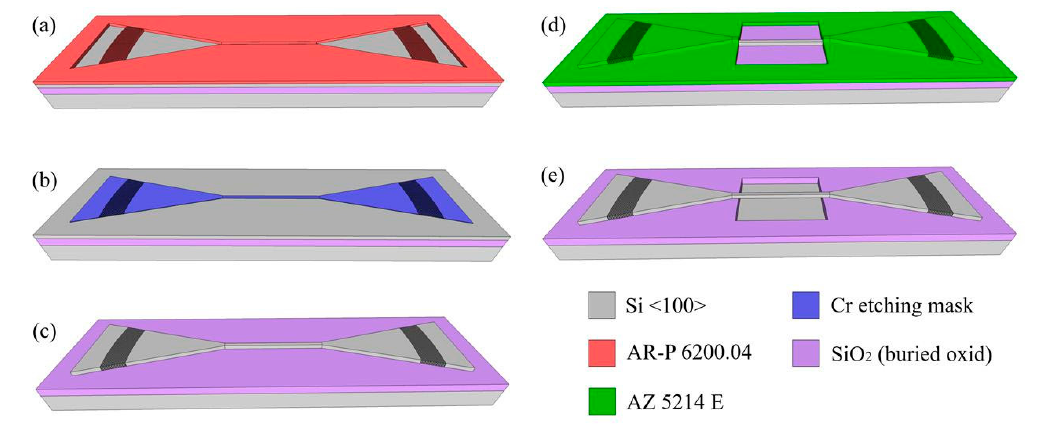
Figure 2. Nanofabrication process sequence on thin-film SOI wafer—device layer (220 nm), buried oxide (3 μ m), handle layer (675 μ m): ( a ) e-beam lithography using 80 nm AR-P 6200.04 (CSAR